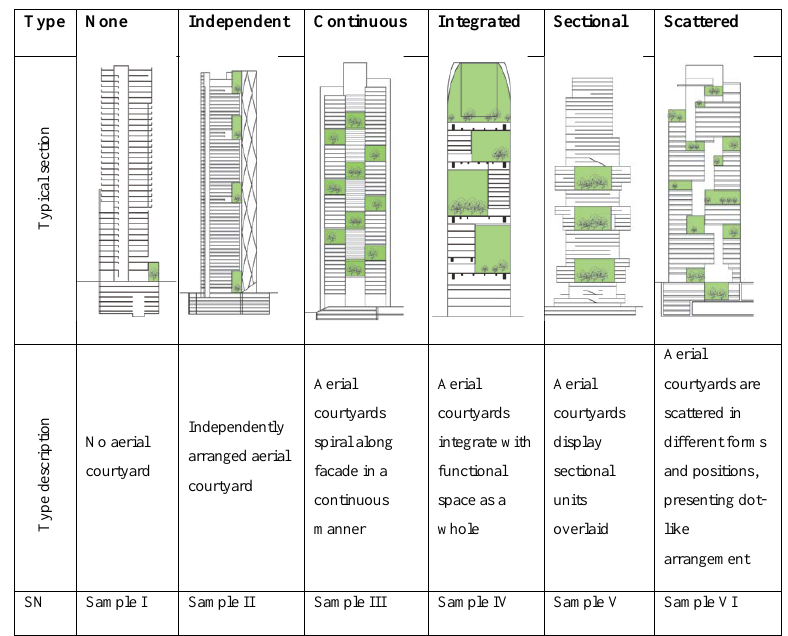
Table 1 Research